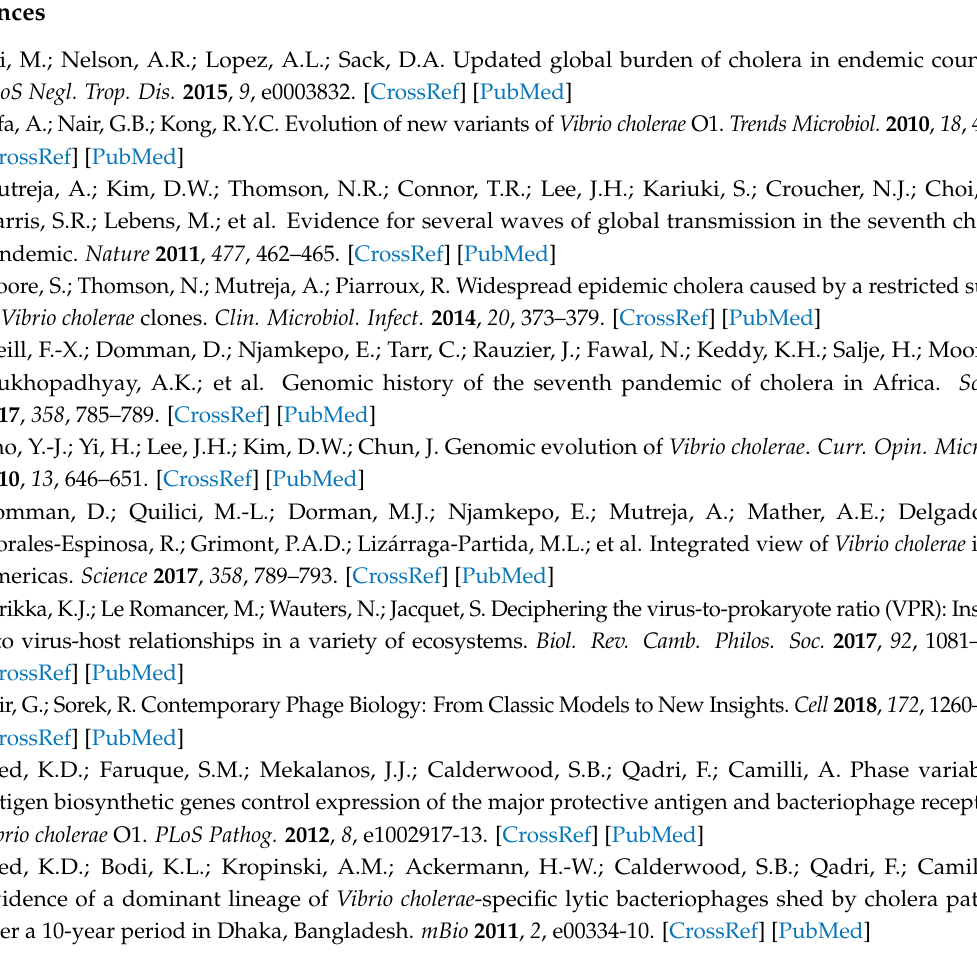
Figure S1: ORF occurrence trends by year and genome length, Table S1: Core-genome ORFs pairwise similarity and CDD hits, Table S2: Accessory-genome ORFs ICP1 strain